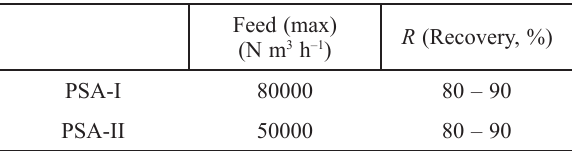
Table 4 – Purifiers data for case study